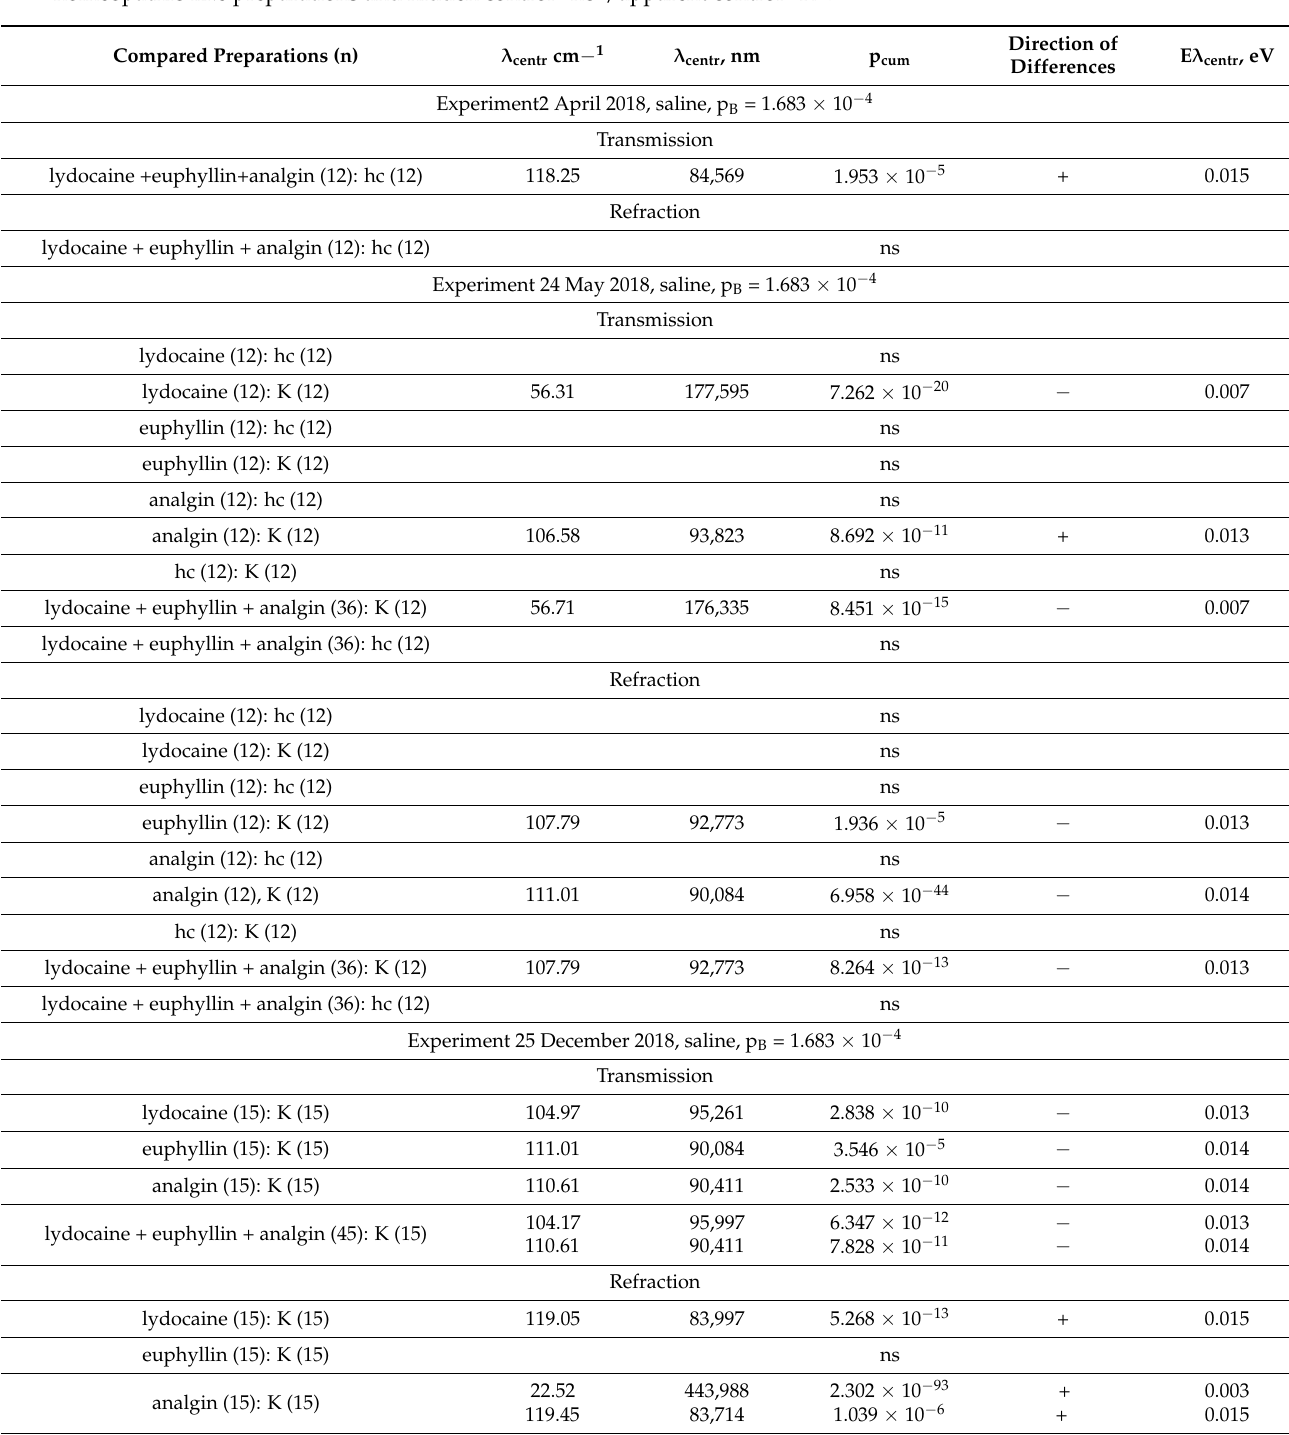
Table 2. Bands of terahertz spectra (transmission and refraction) with significant distinctions between ensembles of homeopathic-like preparations and hidden control “hc”/apparent control